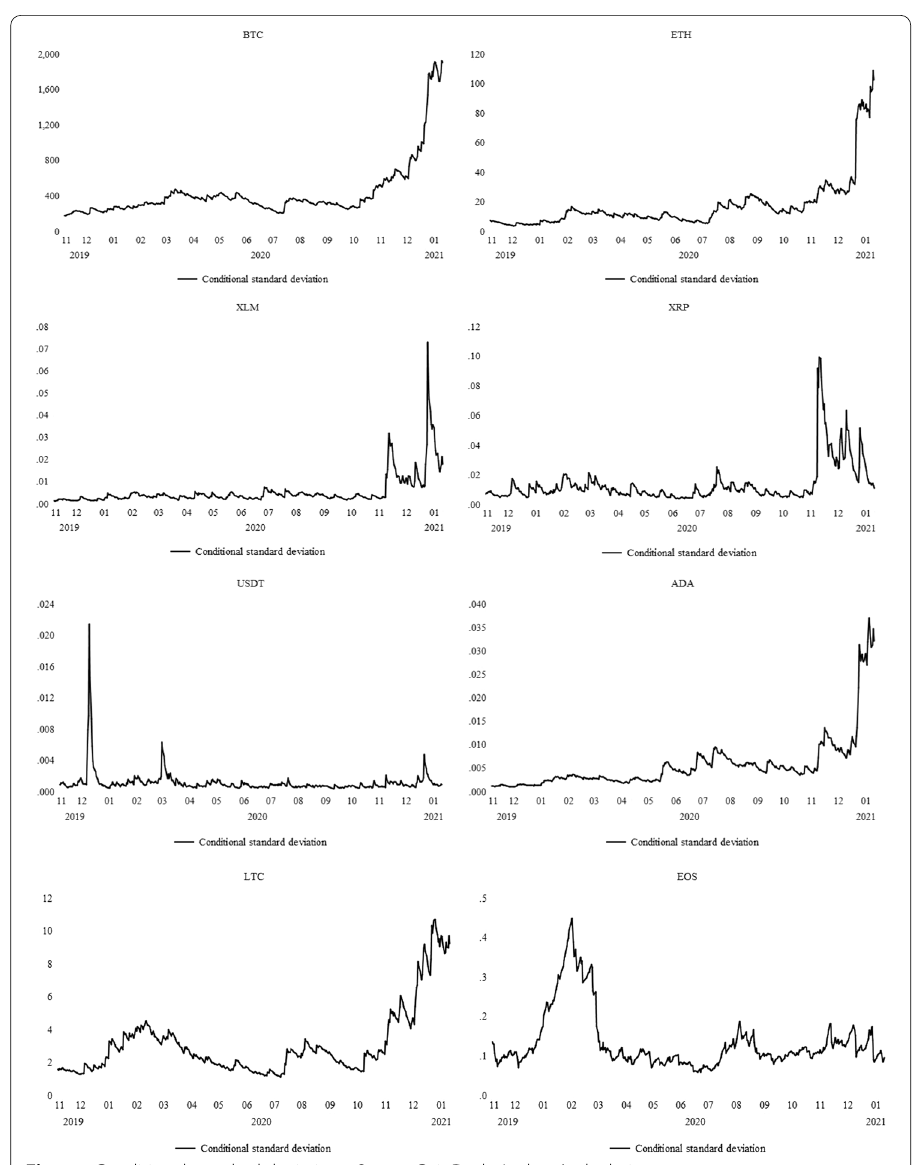
Fig. 14 Conditional standard deviations. Source : CoinDesk, Authors’